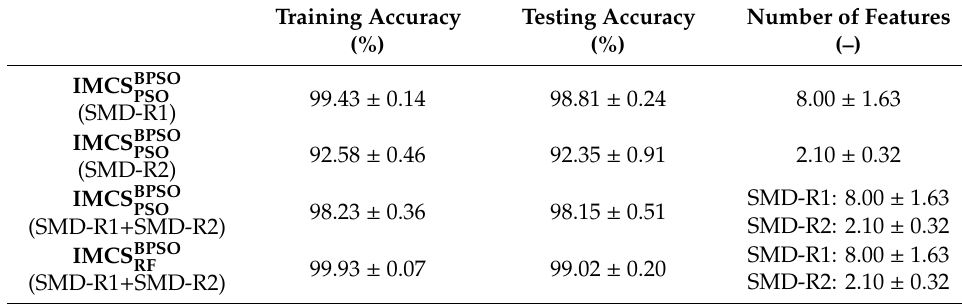
Table 5. Classification performance of the algorithms based on di ff erence MD spaces over 20 independent runs.